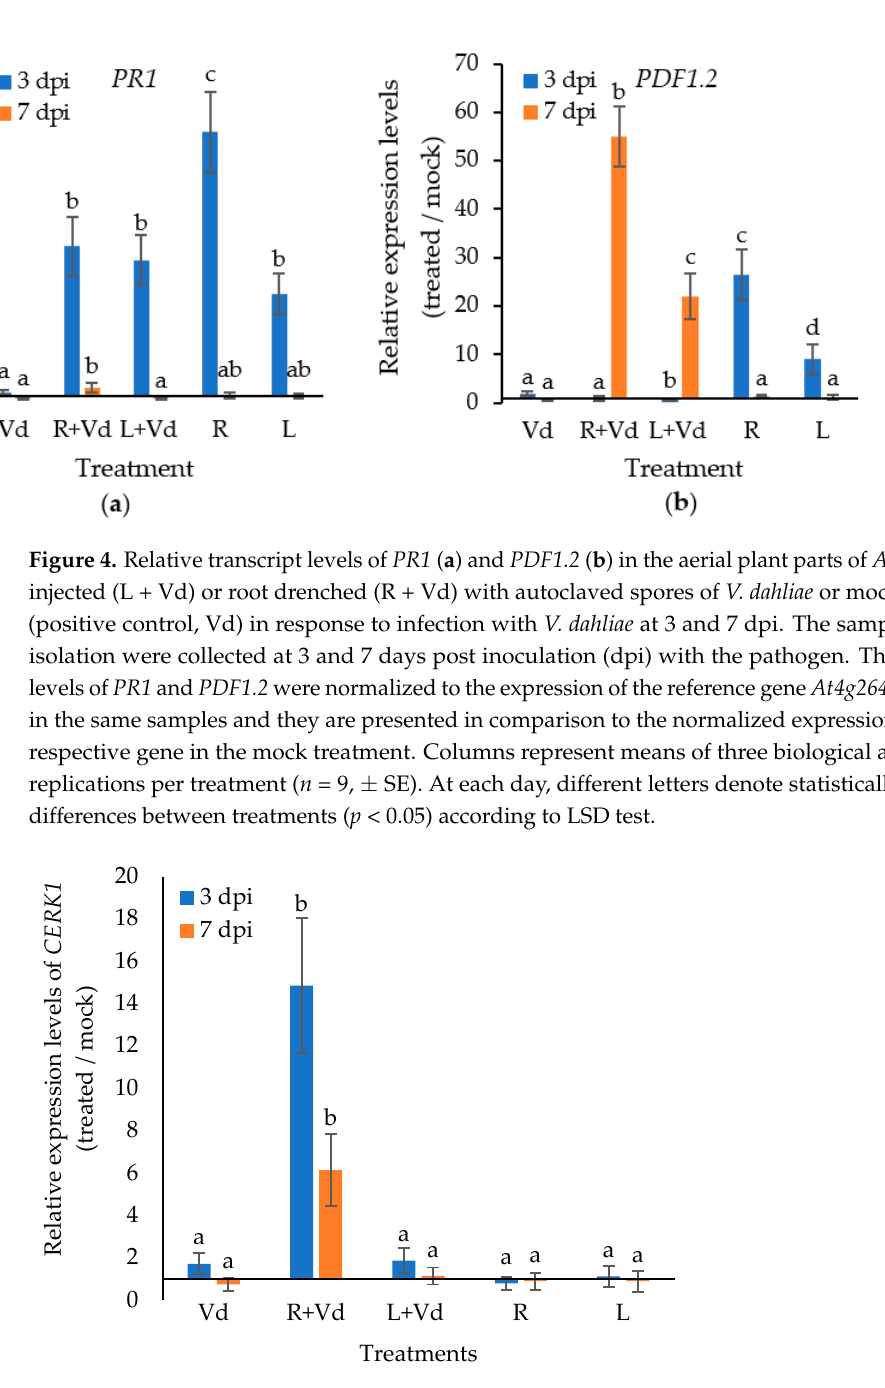
Figure 5. Relative transcript levels of CERK1 in the aerial plant parts of A. thaliana leaf injected (L + Vd) or root drenched (R + Vd) with autoclaved spores of V. dahliae or mock inoculated (positive control, Vd) in response to infection with V. dahliae . The samples for RNA isolation were collected at 3 and 7 days post inoculation (dpi) with the pathogen. The expression levels of CERK1 were normalized to the expression of the reference gene At4g26410 measured in the same samples and they are presented in comparison with the normalized expression level of the respective gene in the mock treatment. Columns represent means of three biological and technical replications per treatment ( n = 9, ± SE). At each day, different letters denote statistically significant differences between treatments ( p < 0.05) according to LSD test.